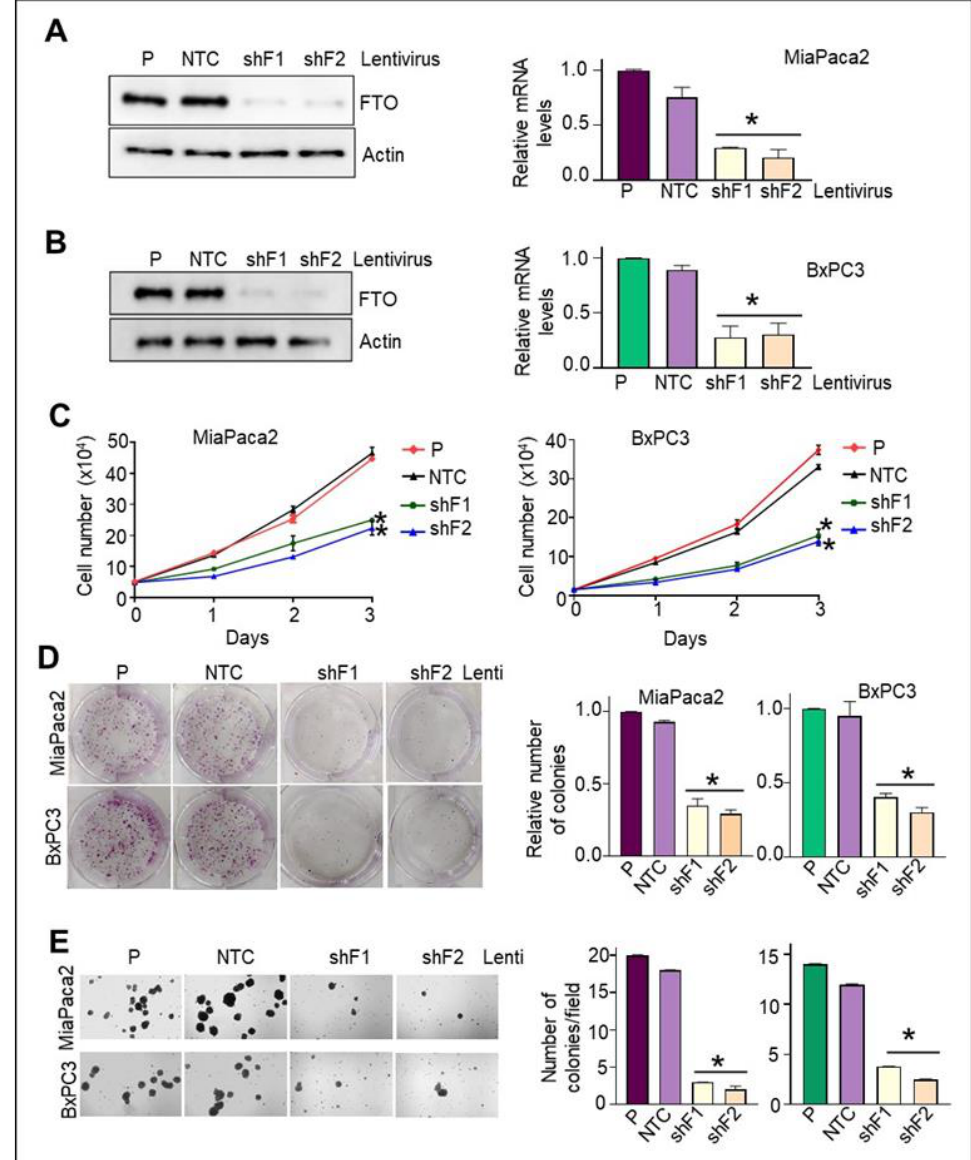
Figure 3. FTO is required for PC cell growth, migration, and invasion. ( A ) FTO stable depletion in MiaPaca2 and BxPC3 was achieved using two different FTO lentiviruses. Control cells were infected with non-target control (NTC) lentivirus. This was followed by selection with puromycin. FTO mRNA and protein expression in following knockdown FTO in PC cells was determined by Western blot and qPCR, respectively. ( B ) MiaPaca2 and ( C ) BxPC3 cells (5 × 10 3 ) were seeded in 96-well plates, and allowed to grow in 2% fetal bovine serum. Cell growth was determined by CCK-8 assay at different time intervals (24, 48, and 72 h). * p < 0.05. ( D ) MiaPaca2 and BxPC3 cells (103) were seeded in MW6, the medium was replaced twice a week, and after 15 days, colonies were stained with crystal violet and counted. Left: Representative photomicrograph is shown. Right: relative quantification of colonies per well. n = 3; * p < 0.05. ( E ) To evaluate anchorage-independent growth, 3 × 10 3 cells were plated in 0.35% agar over a 0.5% agar layer. After 10 days, the plates were stained with 3-(4,5-dimethylthiazol-2-yl)-5-(3-carboxymethoxyphenyl)-2-(4-sulfophenyl)-2H-tetrazolium (MTS). The number of colonies was counted in five different fields and averaged for each well. Data are expressed as mean ± SD of triplicate measurements. * p < 0.05. Original Western blots are available as supplementary material.